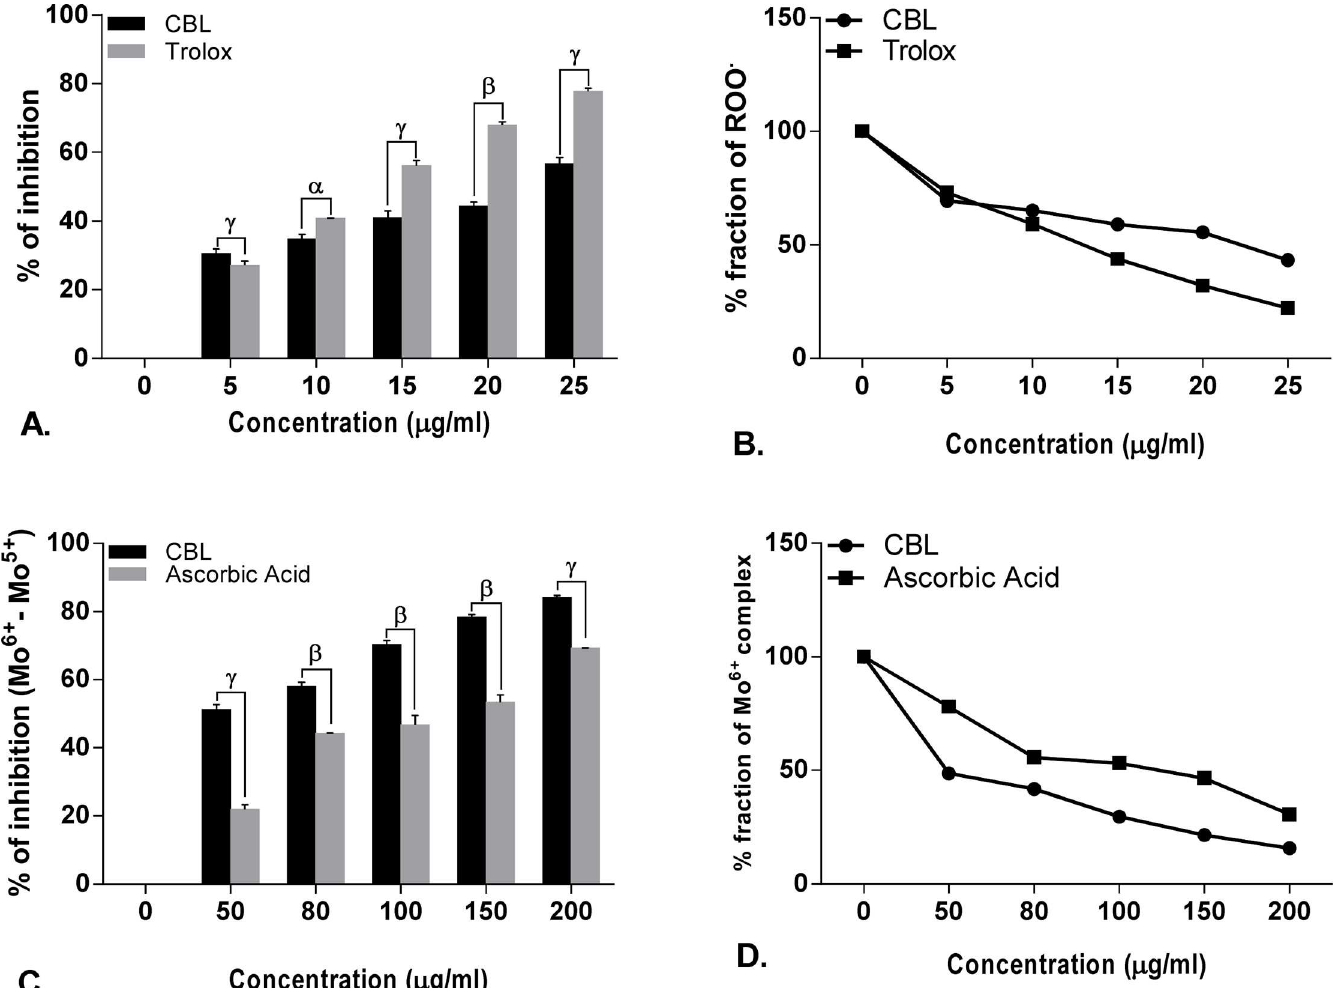
Fig 3. Antioxidant activity of Croton bonplandianus . (A) & (B) concentration dependent Total antioxidant activity and extent of Mo 6+ reduction; (C) % inhibition of lipid peroxidation Vs standard trolox; (D) depicts remaining unneutralized lipid peroxides (ROO • ). Data expressed as mean ± S.D (n = 6). α p < 0.05; β p < 0.01; γ p < 0.001; NS-Non significant when compared with